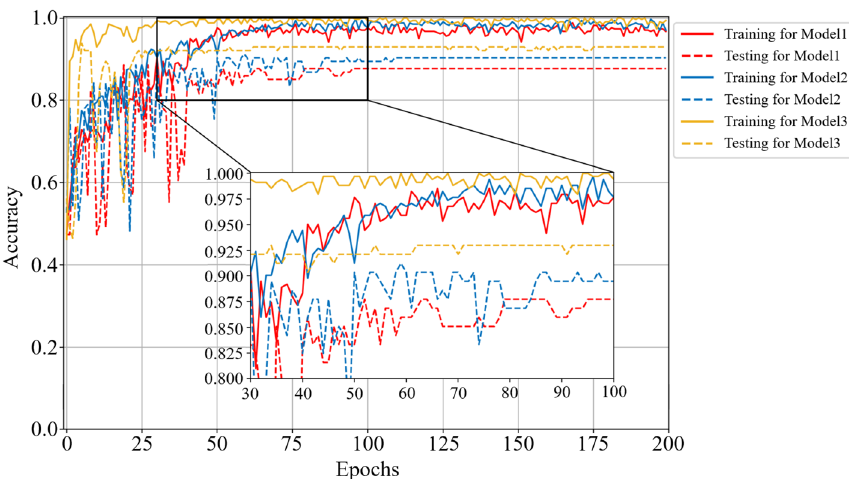
Figure 9. Comparison curves of accuracy performance of different models on simulated site dataset.